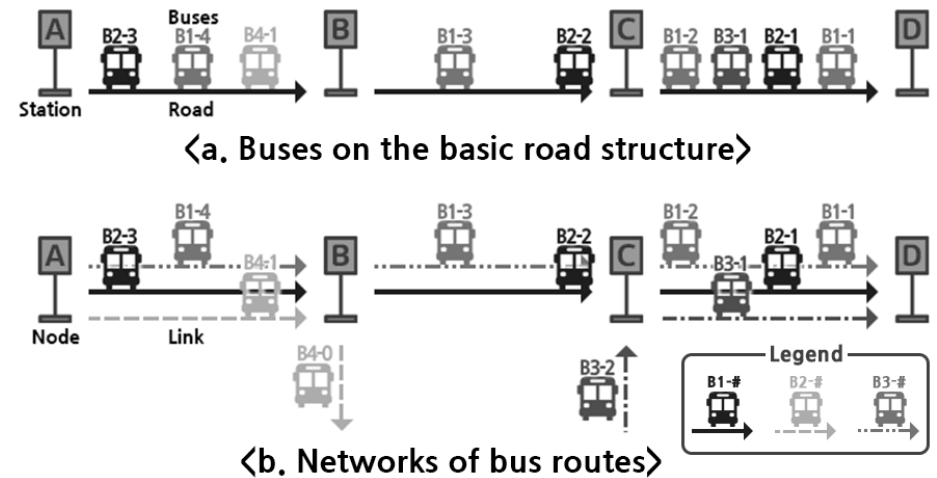
Figure 2. Buses on the basic road structures and the network per bus routes. Symbols A, B, C, and D represent bus